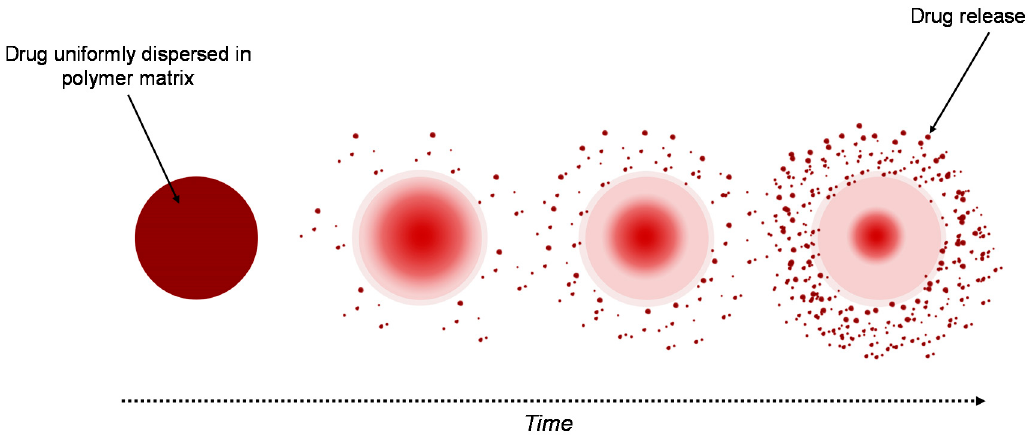
Figure 3. Drug delivery from a matrix system.